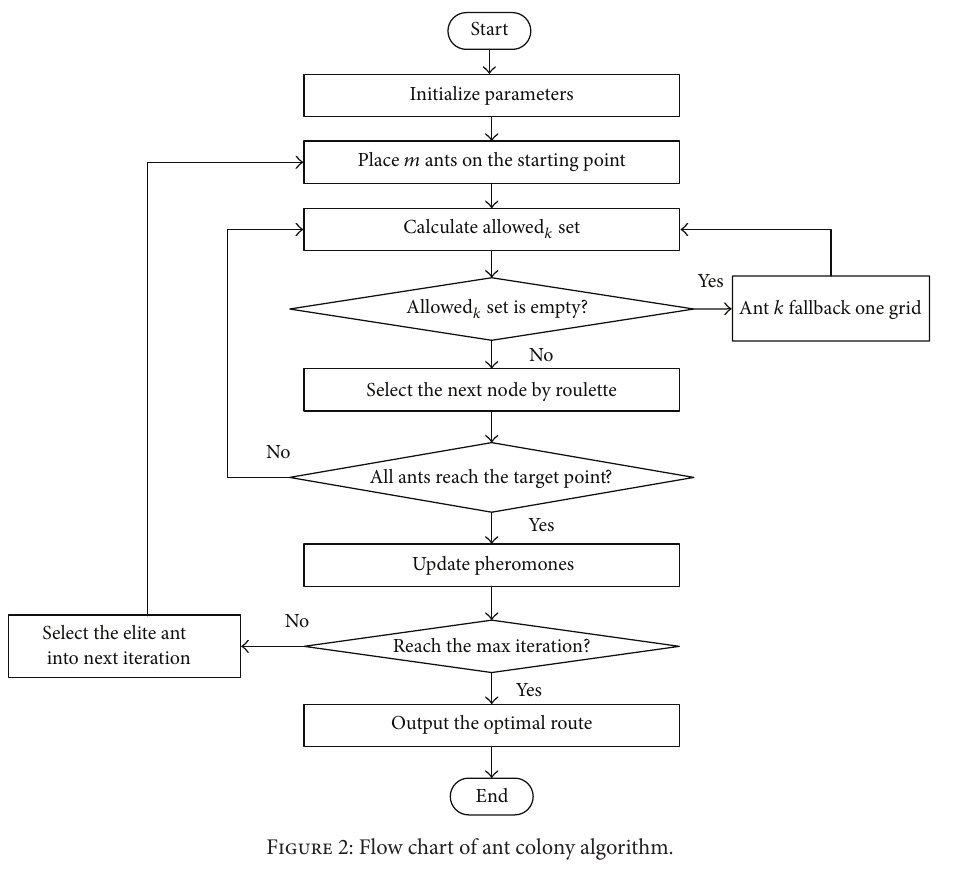
Figure 2: Flow chart of ant colony algorithm.